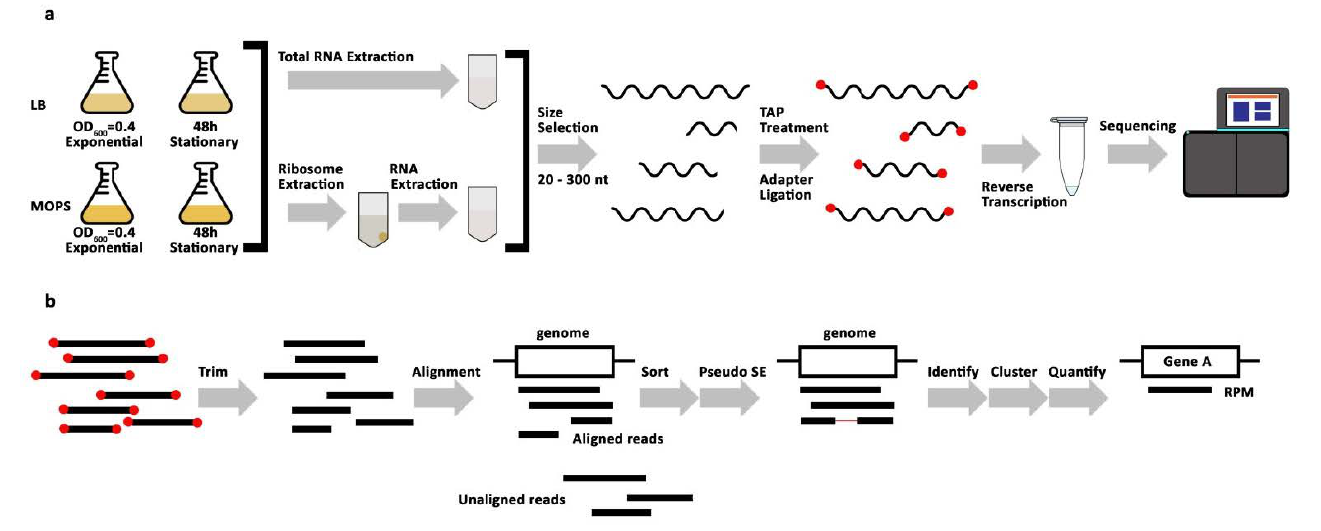
Figure 1. Sequencing library preparation and analysis workflow. ( a ) Schematic representation of sequencing library preparation: E. coli were cultured in two different media, lysogeny broth (LB) and morpholinepropanesulfonic acid (MOPS), and in two biological replicates. Samples were taken at the indicated time points (OD600 = optical density measured at 600 nm, h = hour). From each growth condition, samples were used for total RNA extraction and crude ribosome extraction, followed by RNA extraction. RNA was size extracted from polyacrylamide gels with 20–300 nt cutoffs (nt = nucleotides). Size selected RNA was Tobacco Acid Pyrophosphatase (TAP) treated then reverse-transcribed with 5 (cid:48) - and 3 (cid:48) - adapters to make cDNA libraries. cDNA libraries were sequenced. ( b ) Workflow of Stable RNA Processing Product Analyzer (STARPA) analysis: Reads were trimmed from adapter sequences then aligned to the E. coli reference genome. Unaligned reads were discarded in a sorting step. Reads with paired-ends were transformed into pseudo-single-end (SE) reads. The remaining reads were identified, clustered by sequence or by overlap, and then quantified (RPM = reads per